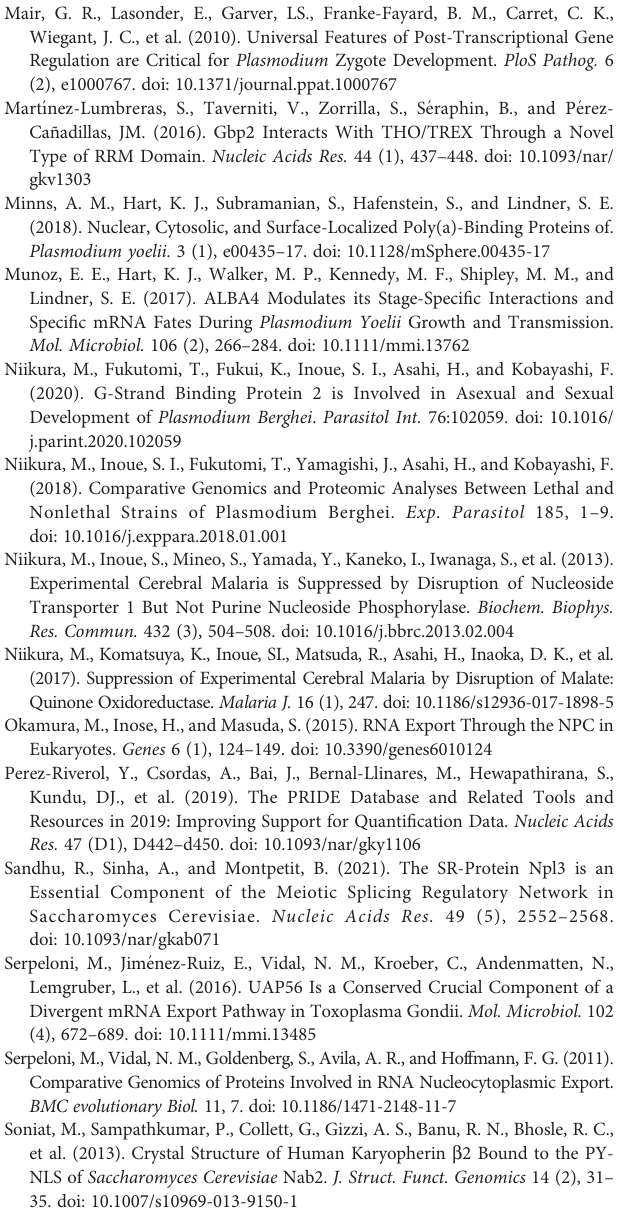
Supplementary Figure S2 | Generation of parasites to investigate localizations of GBP2 and NAB2. Schematic representation of the gene-targeting vectors used to express GBP2::mCherry, NAB2::mCherry and NUP205::GFP fusion proteins. The gene-targeting vector contained mCherry or green fl uorescent protein ( gfp ), human